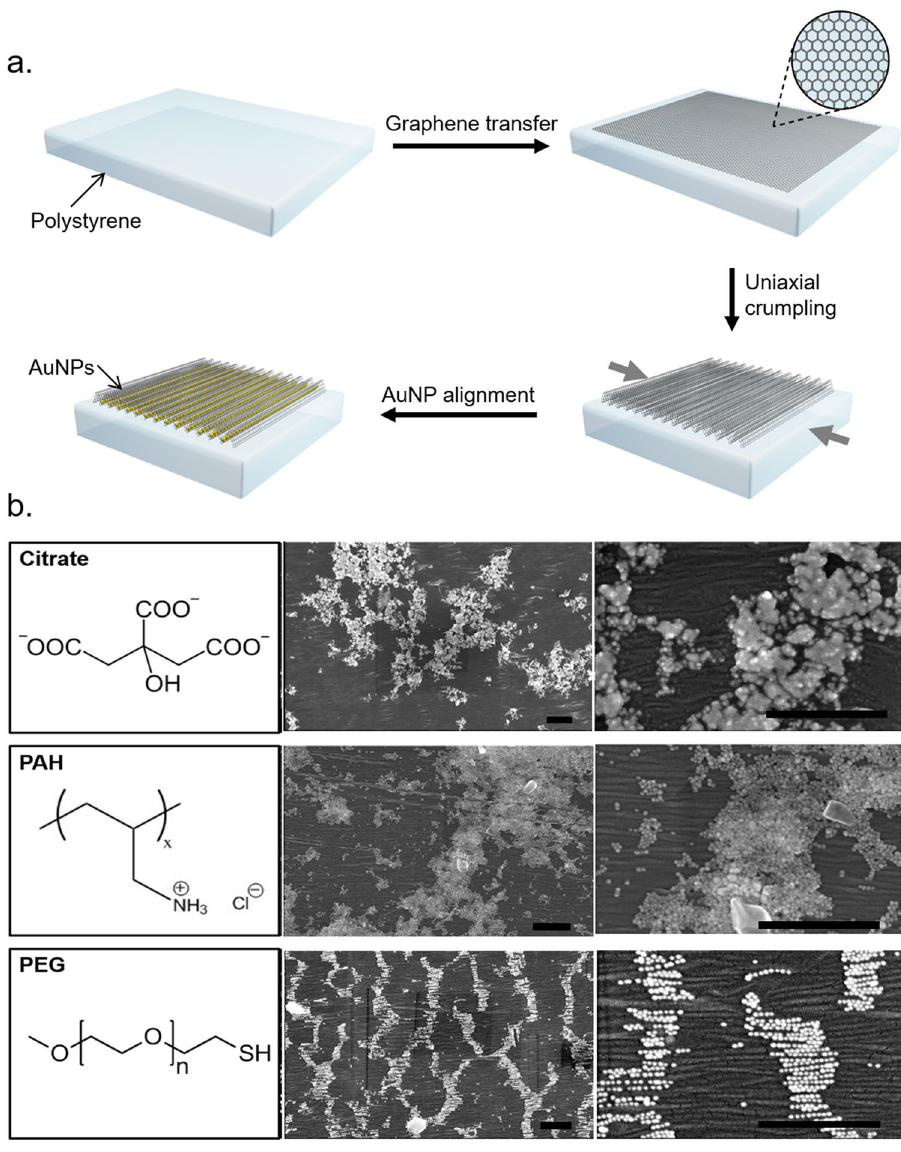
Figure 1. Schematic of graphene buckle delamination and gold nanoparticle assembly, and SEM images of gold nanoparticles with varying surface chemistry deposited onto buckle delaminated graphene. Schematic of graphene buckle delamination and gold nanoparticle assembly ( a ). SEM images of 20 nm AuNPs with citrate, poly(allylamine hydrochloride), and poly(ethylene glycol) surface coatings, after deposition and drying on graphene substrates ( b ). All scale bars 500 nm. Schematic was created with Autodesk 3ds Max software (version 2018, http:// www. autod esk.